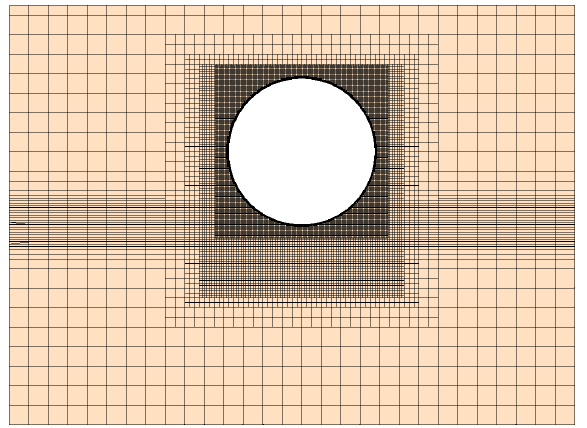
Figure 2. Computational mesh on a plane section.